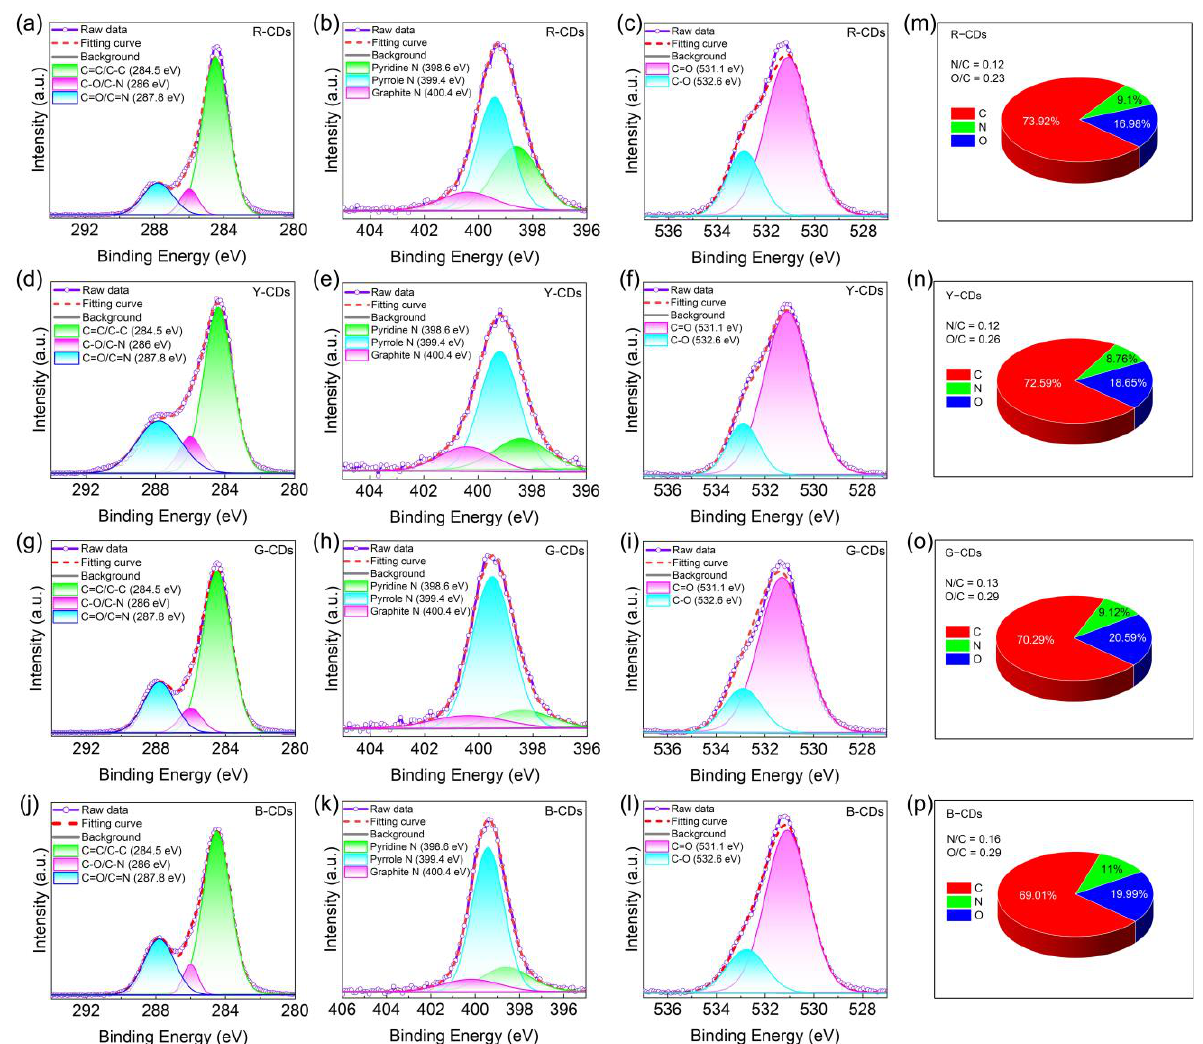
Figure 7. The high-resolution XPS spectra of the R-CDs ( a – c ), Y-CDs ( d – f ), G-CDs ( g – i ), and B-CDs ( j – l ) for C1s, N1s, and O1s. The quantitative analysis of XPS for the R-CDs ( m ), Y-CDs ( n ), G-CDs ( o ), and B-CDs ( p ).